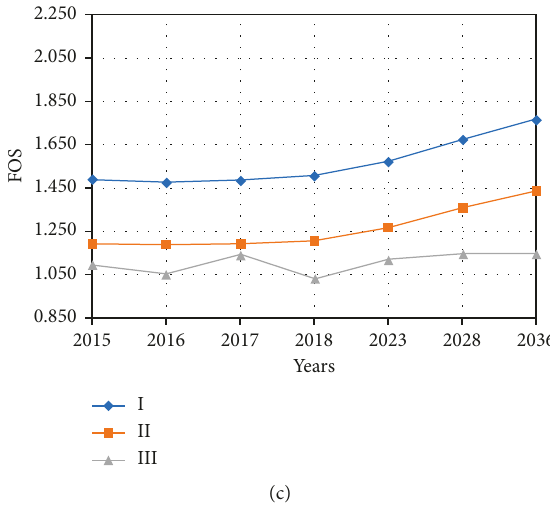
Figure 14: FOS comparisons for Hornfels Waste Dump by years and conditions. (a) FOS comparison of partial slope for circular sliding. (b) FOS comparison of overall slope for circular sliding. (c) FOS comparison of sliding along contact between foundation and waste rock